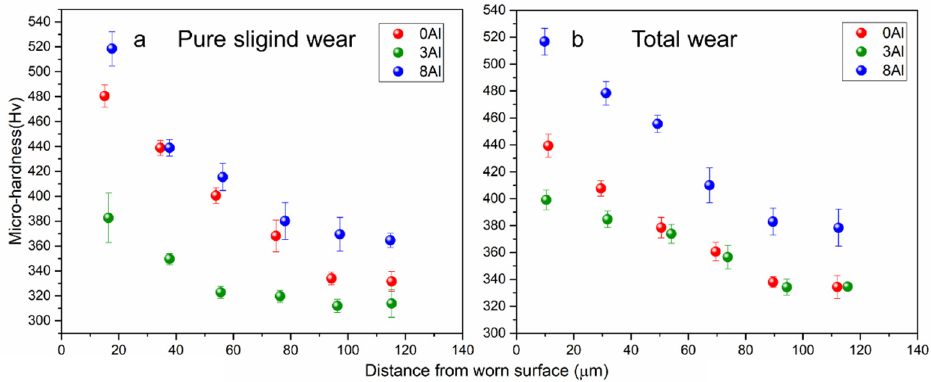
Figure 14. Hardening profiles of the alloys after ( a ) pure sliding wear and ( b ) total wear tests.